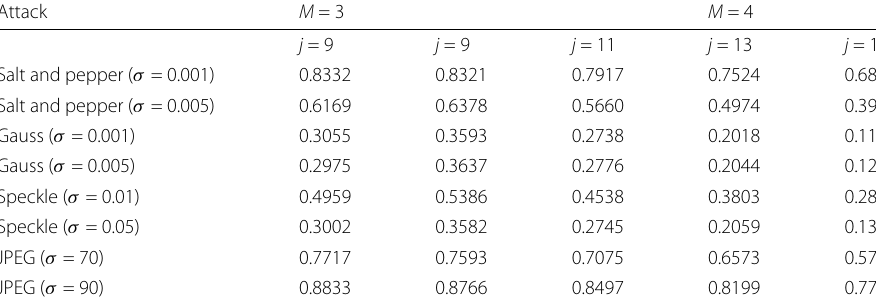
Table 4 Robustness under different attack with different